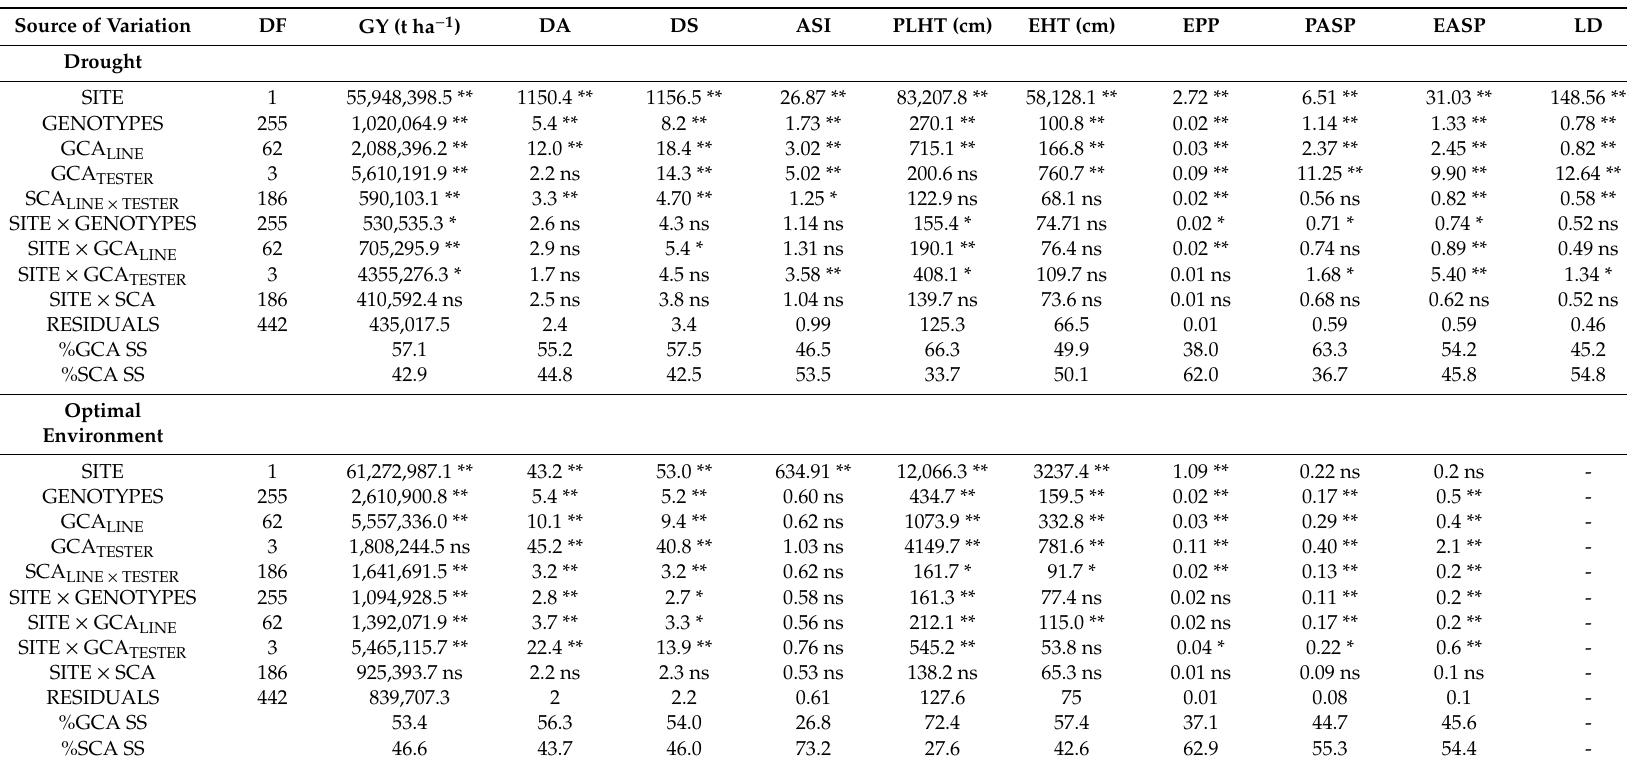
Table 1. Mean squares of general combining ability (GCA) and specific combining ability (SCA) of grain yield and other agronomic traits of extra-early maturing maize hybrids evaluated under induced drought at Ikenne during the 2013 and 2014 dry seasons and under optimal growing conditions at Bagauda and Ikenne during the 2014 rainy